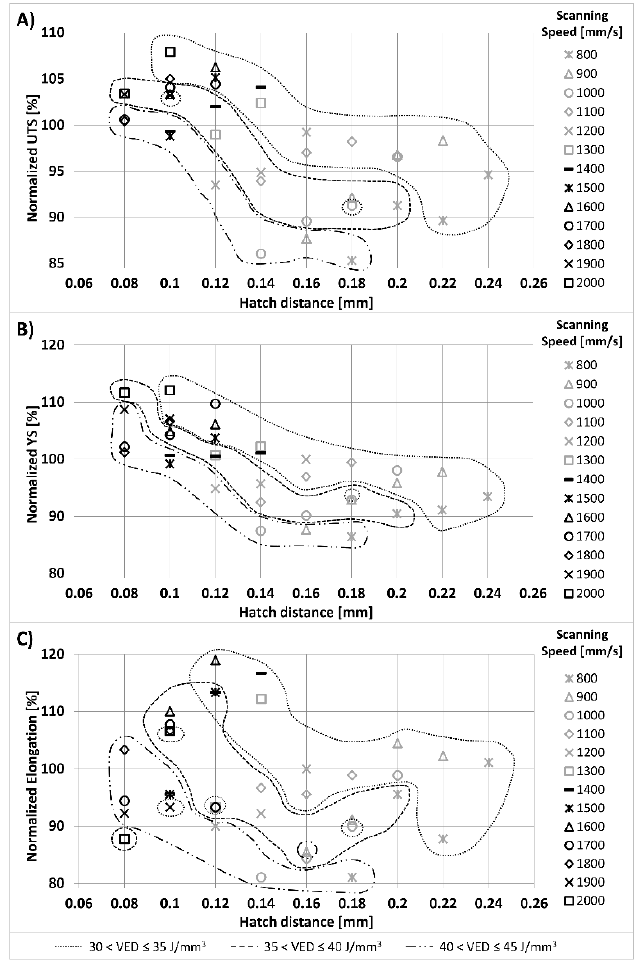
Figure 2. Mechanical properties of parts built with the setups considered in step 1 of the analysis. Domains corresponding to different VED ranges are identified by dashed contours. ( A ) Normalized UTS; ( B ) Normalized YS; ( C ) Normalized elongation.